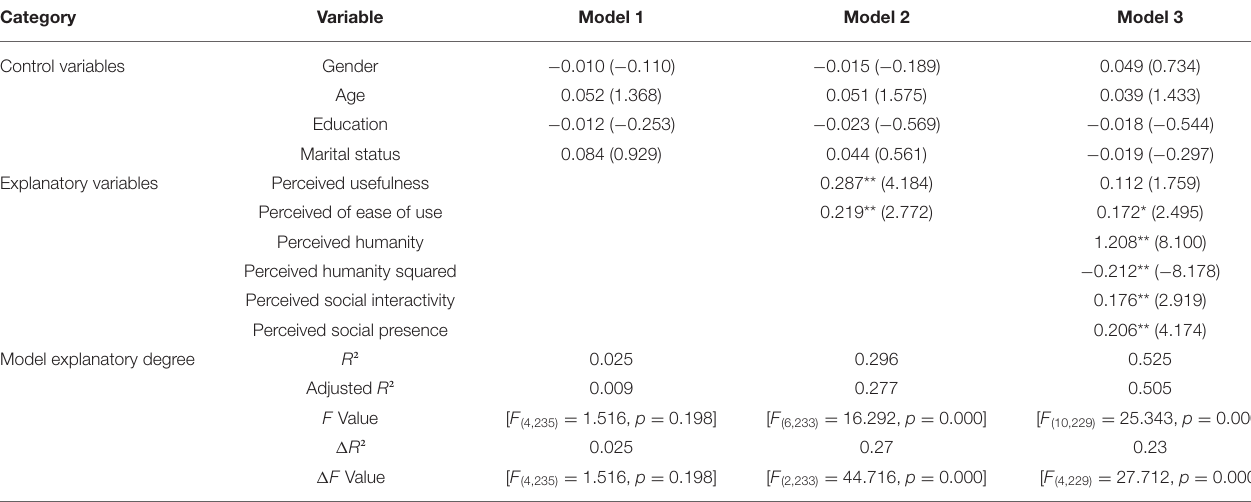
TABLE 6 | Results of multilevel regression tests (Explanatory variable: Trust).